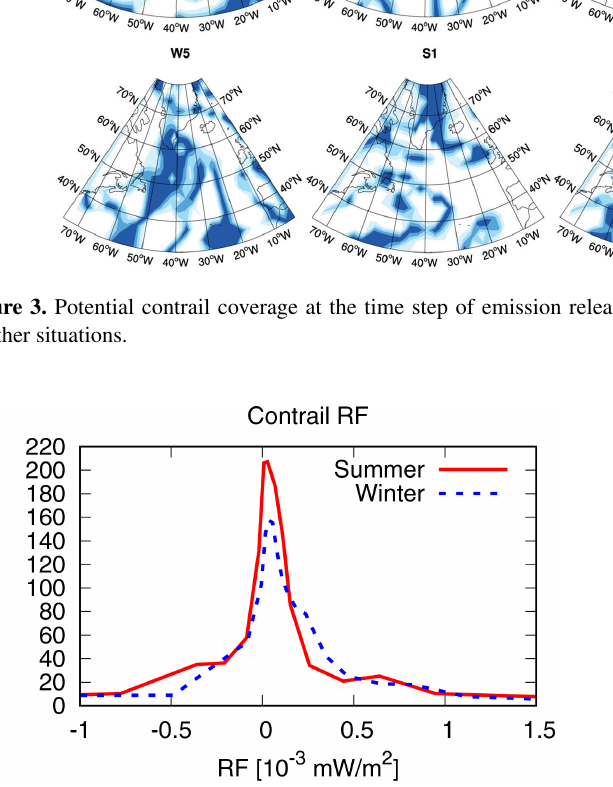
Figure 4. Probability density function of contrail net RF for winter and summer weather situations.